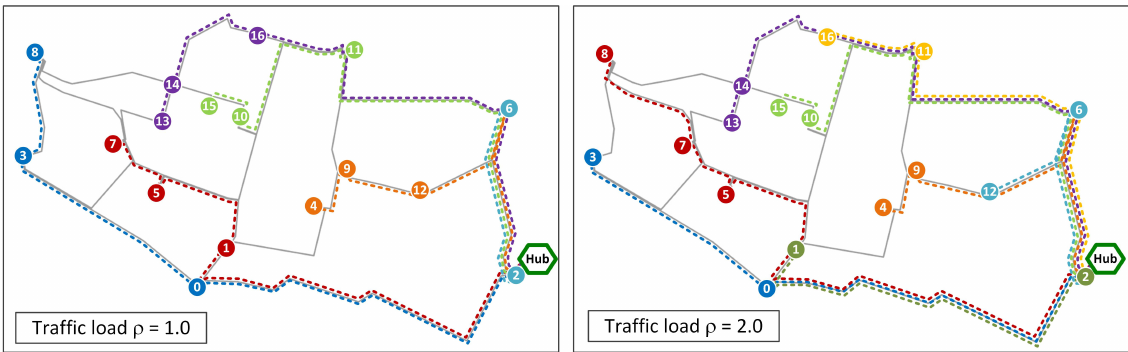
Figure 4. Optimal solutions obtained in WRO17 for traffic load ρ = 1.0 ( left ) and ρ = 2.0 ( right